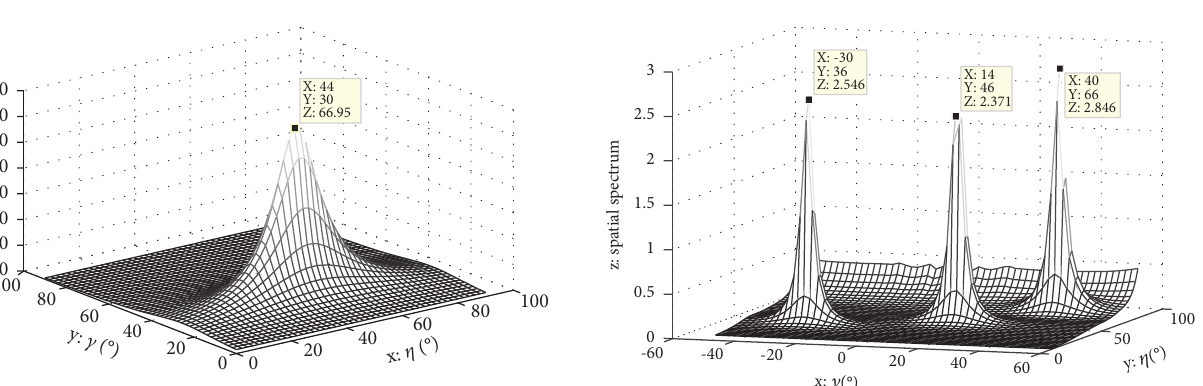
Figure 6: Polarization estimation with ( θ , ϕ ) � ( 45 ° , 15 ° ) .